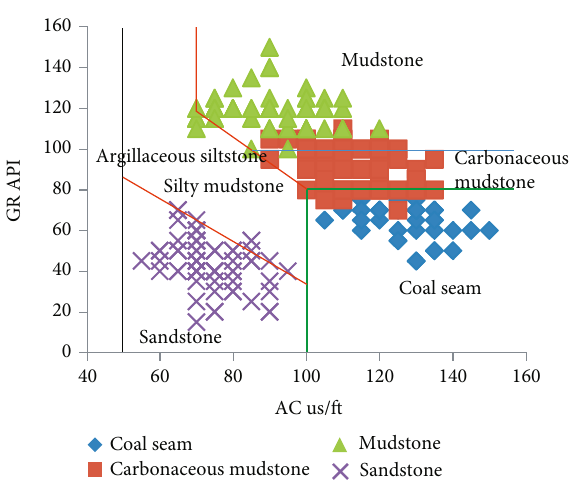
Figure 4: Logging di ff erentiation of lithology in reservoir sandstone, source rock, and transition